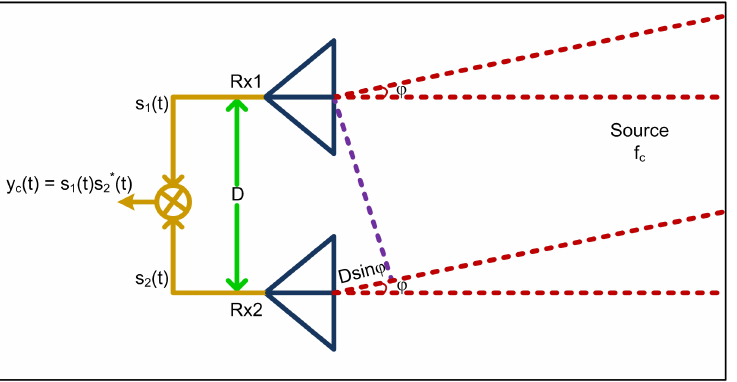
Figure 3. The interferometric radar schematic